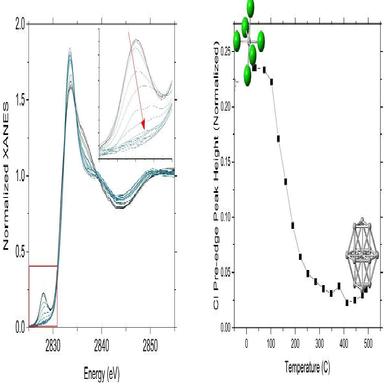
Cl K-edge XANES during TPR from RT to 500 °C with inset showing pre-edge peak (A). Cl pre-edge peak height as a function of temperature (B).